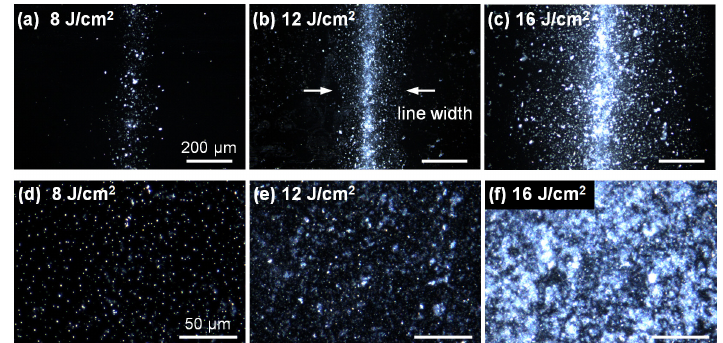
Figure 2. Dark field microscope images of the LTNS lines obtained at ( a ) 8 J/cm 2 , ( b ) 12 J/cm 2 , and ( c ) 16 J/cm 2 . The white arrows in ( b ) indicates line width. LTNS films obtained at ( d ) 8 J/cm 2 , ( e ) 12 J/cm 2 , and ( f ) 16 J/cm 2 . Scale bars in figures ( b , c ) and ( e , f ) indicate 200 µ m and 500 µ m, respectively.